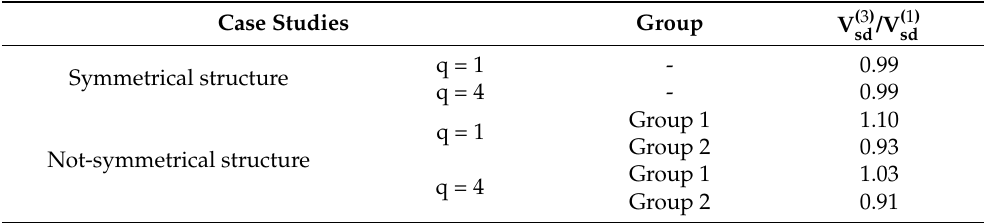
Table 11. Ratios between the shears from the linear dynamic analysis with corrected stiffness, and linear static analysis for one-floor building case studies.